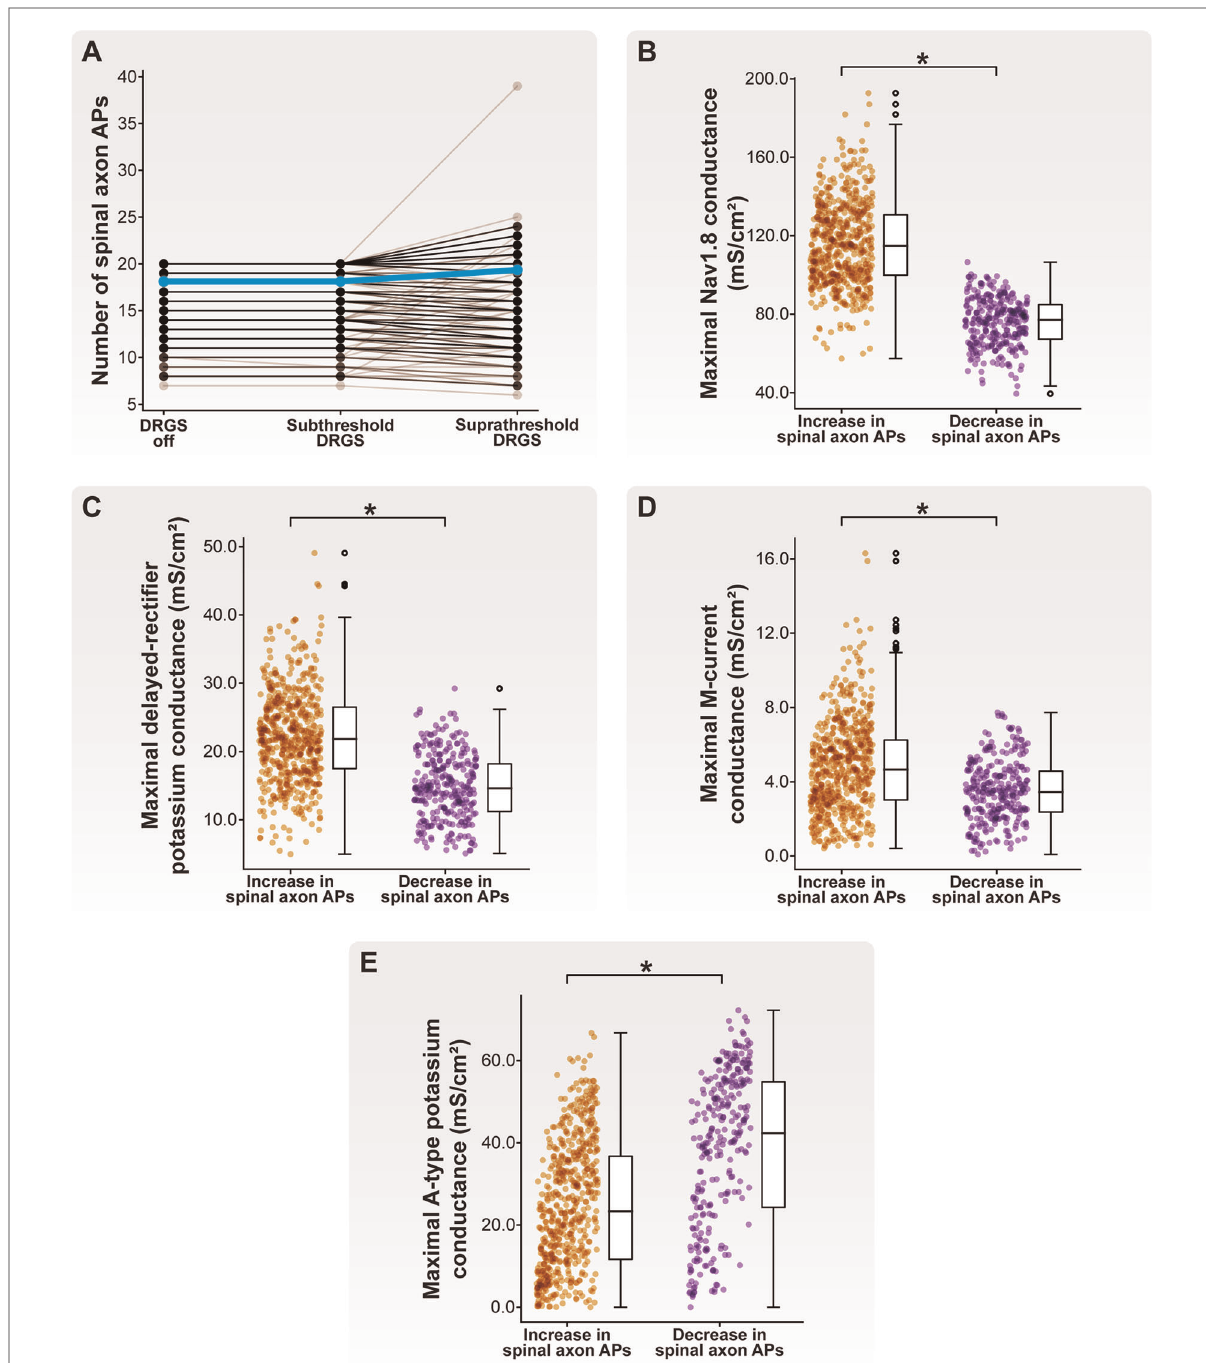
FIGURE 9 Effect of stimulus pulse amplitude on AP propagation through the T-junction during 20 Hz cathodic- fi rst DRGS. ( A ) Each brown line corresponds to an individual model C-neuron, and each blue line corresponds to the model population average. Increasing the DRGS pulse amplitude from subthreshold to suprathreshold amplitudes caused some model C-neurons to increase the number of APs propagating through their T-junction, while others decreased the number of APs. ( B – E ) Comparing biophysical properties of model C-neurons which increased or decreased the number of APs propagating through their T-junctions in response to increasing DRGS pulse amplitude from a subthreshold to suprathreshold level. Model C-neurons which decreased the number of APs propagating through their T-junctions had lower maximal conductances of ( B ) Nav1.8, ( C ) delayed-recti fi er potassium, and ( D ) M-current, but ( E ) higher maximal A-type potassium channel